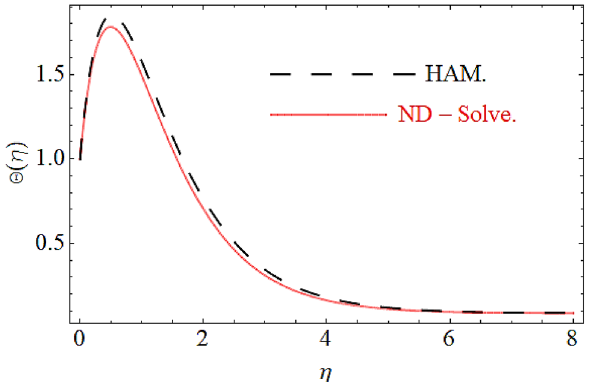
Figure 22. Comparison of HAM and ND-Solve in case of �(η) .